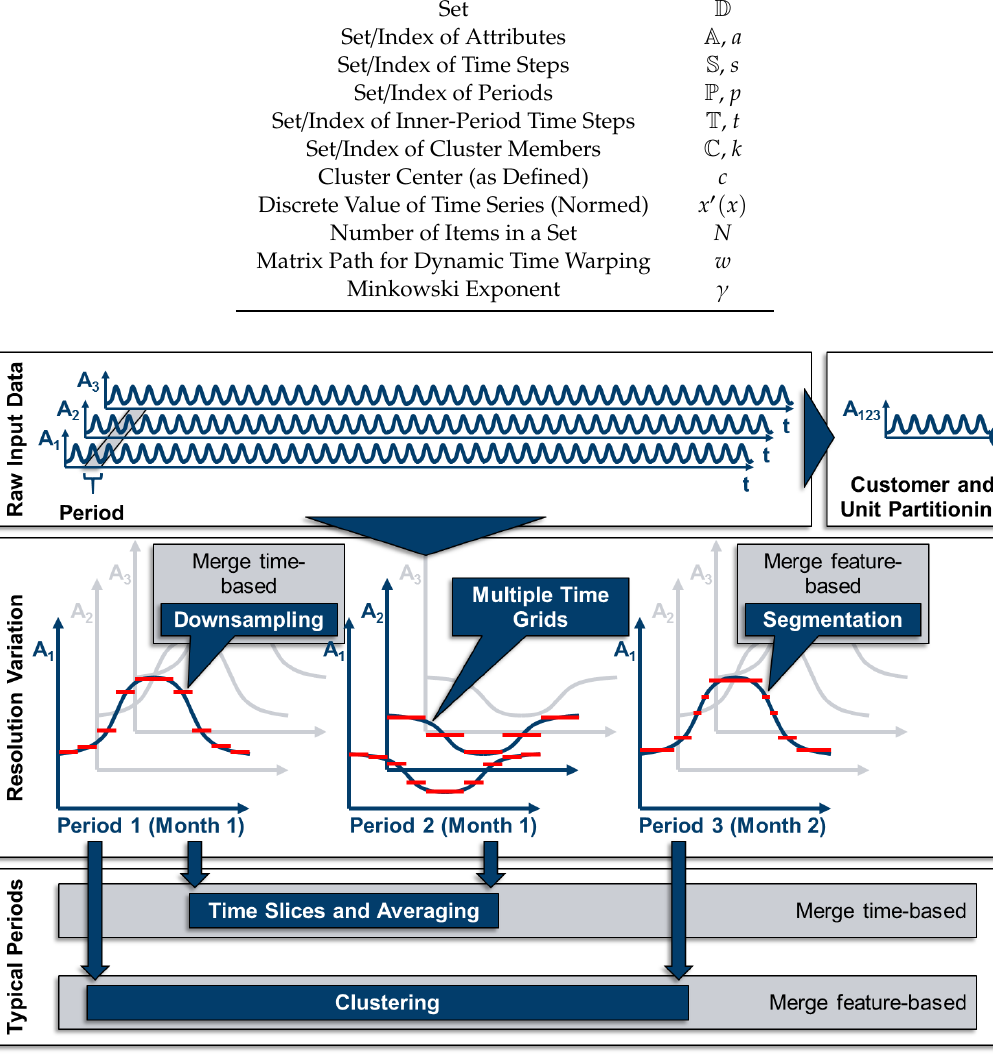
Figure 4. Methods of time series aggregation (TSA) for energy system models (ESMs).